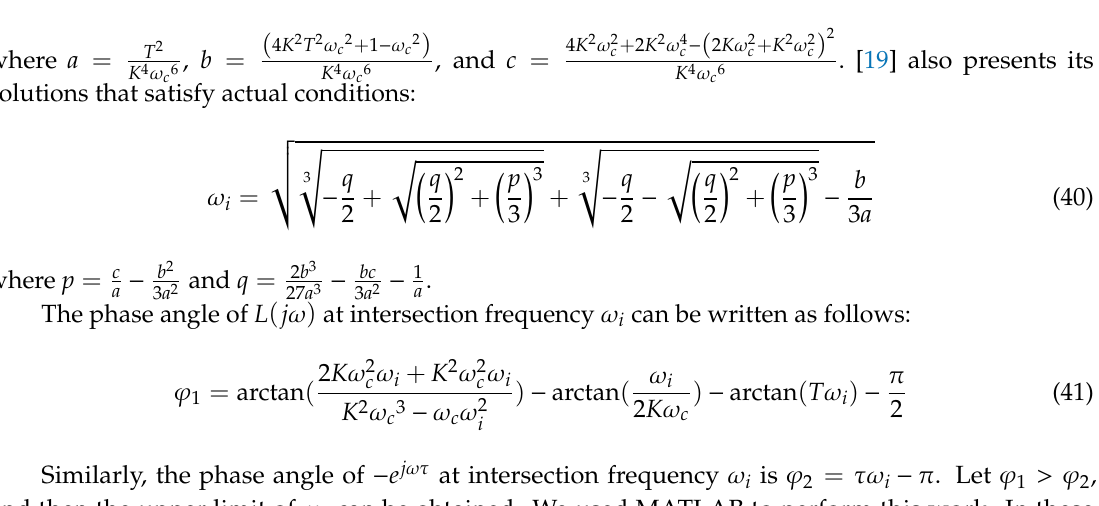
Figure 5. Step Response When 𝜔 (cid:3030) = 0.1505 and 𝐾 = 10 .